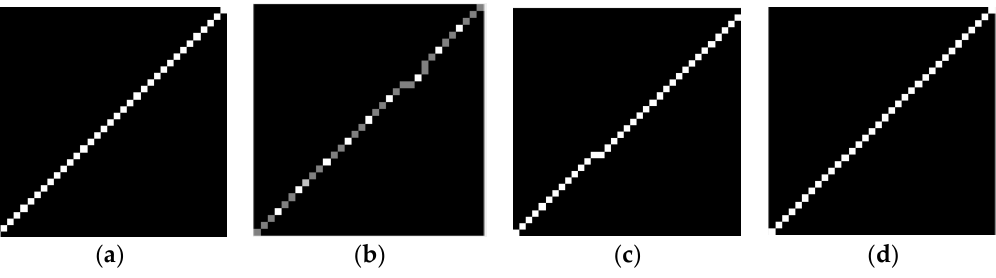
Figure 10. Blur kernel determined by a different method. ( a ) The true blur kernel. ( b ) The blur kernel obtained by gyroscope. ( c ) The blur kernel obtained by improved Radon transform. ( d ) The blur kernel obtained by the proposed method.